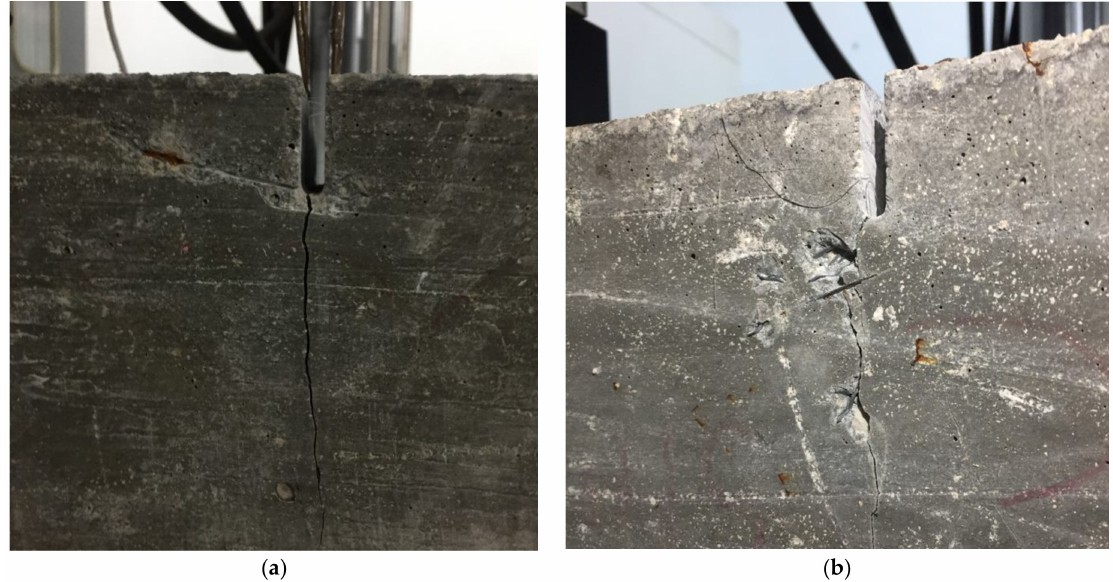
Figure 12. Cracking of concrete in the fatigue test specimen side 1 ( a ) and specimen side 2 ( b